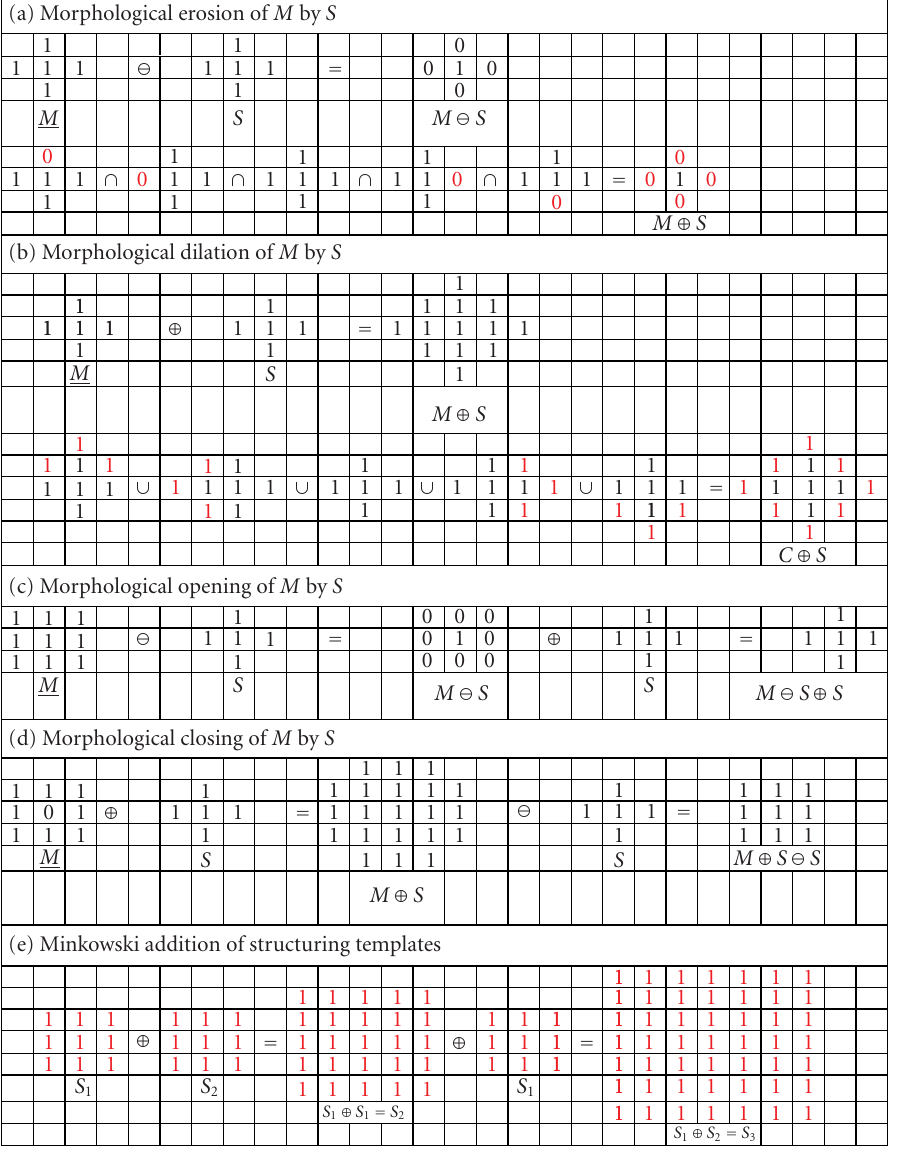
Figure 2.1. Matrix representation of morphological transformations and certain logical operations. These transformations are performed with the help of S centered on m